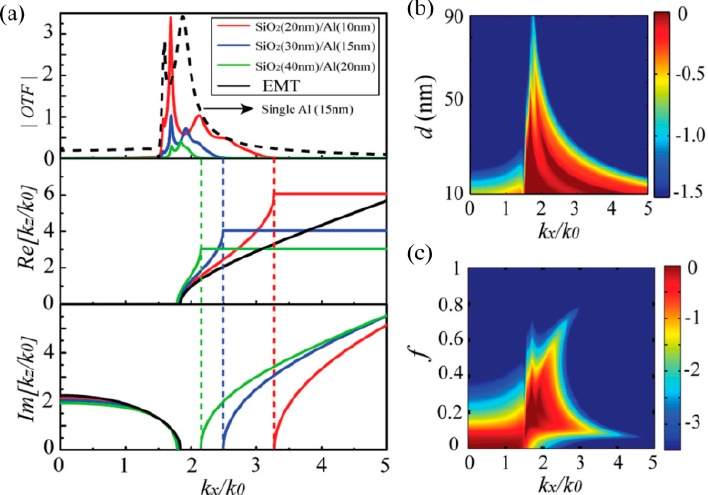
Figure 6. ( a ) Top panel is the calculation of optical transmission function (OTF) for SiO 2 /Al films